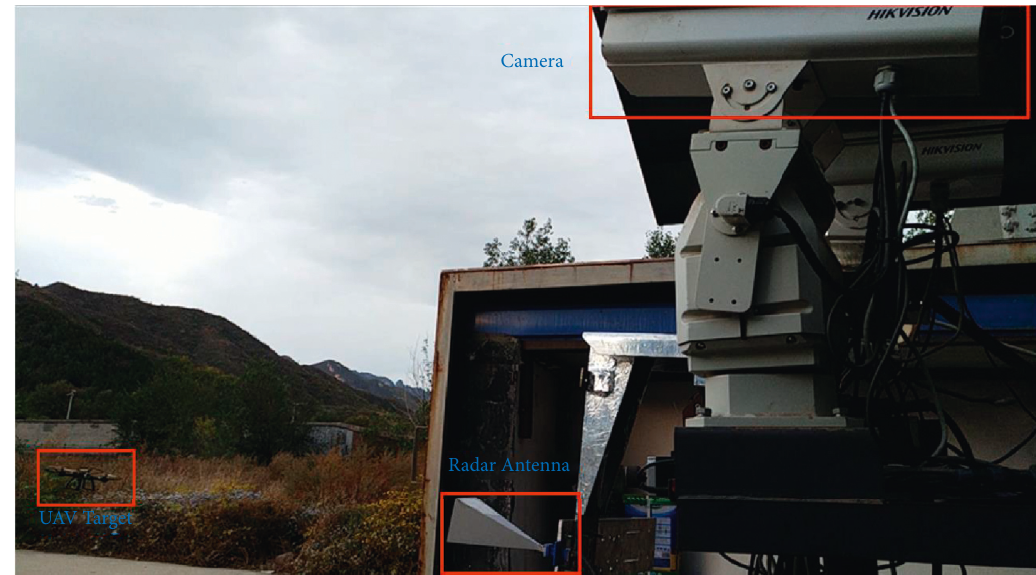
Figure 9: The experimental environment.